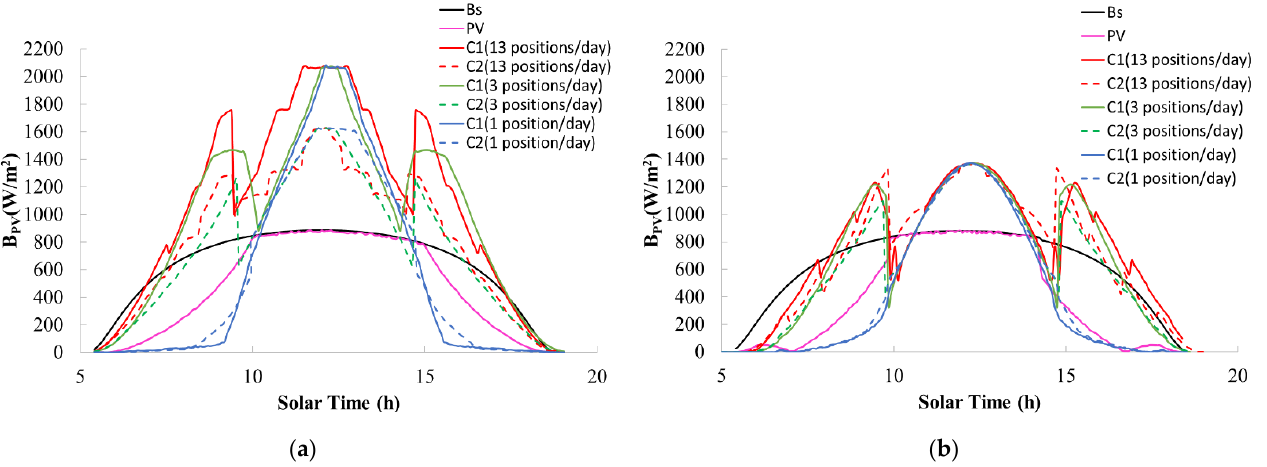
Table 2. The mirror inclination angles when fixed at three positions for double and partial coverage (for the city of Jeddah).